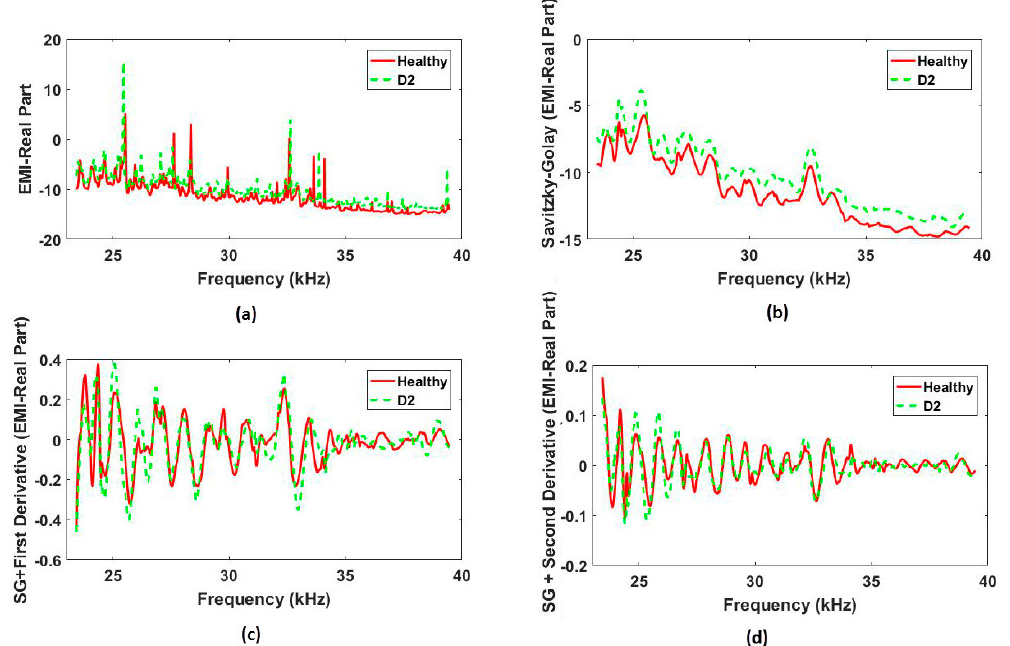
Figure 8. Real part of the EMI signatures considering two structural conditions (H and D2) for PZT#2: ( a ) raw EMI; ( b ) EMI signals smoothed by Savitzky-Golay (SG); ( c ) EMI signals smoothed by SG, followed by application of the first derivative; and, ( d ) EMI signals smoothed by SG, followed by application of the second derivative.